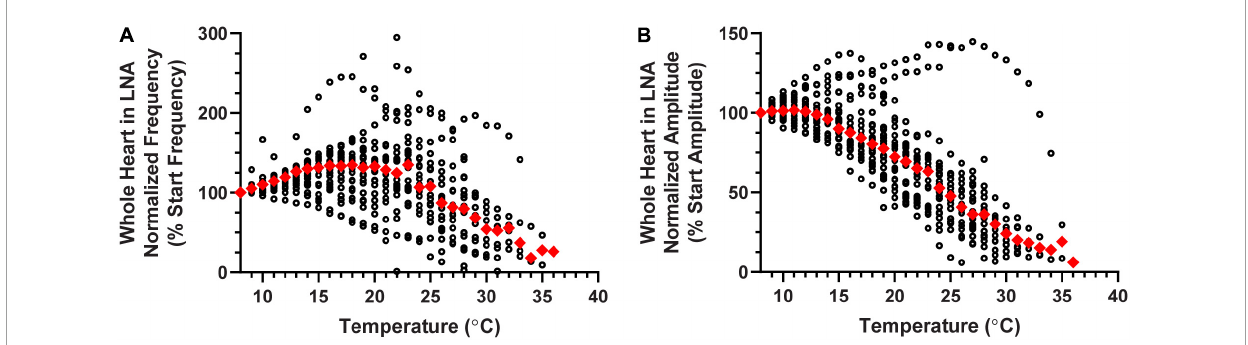
FIGURE9 Whole heart responses to a temperature ramp in LNA. Plot of (A) normalized contraction frequency and (B) normalized contraction amplitude measured in the whole heart as a function of temperature during LNA perfusion. Contraction frequency (A) increases until about 20 ◦ C, at which point it begins to decrease with increased temperature. Contraction amplitude (B) began to decrease at temperatures greater than 13 ◦ C. Red triangles represent the median response at each temperature step for panels (A,B)